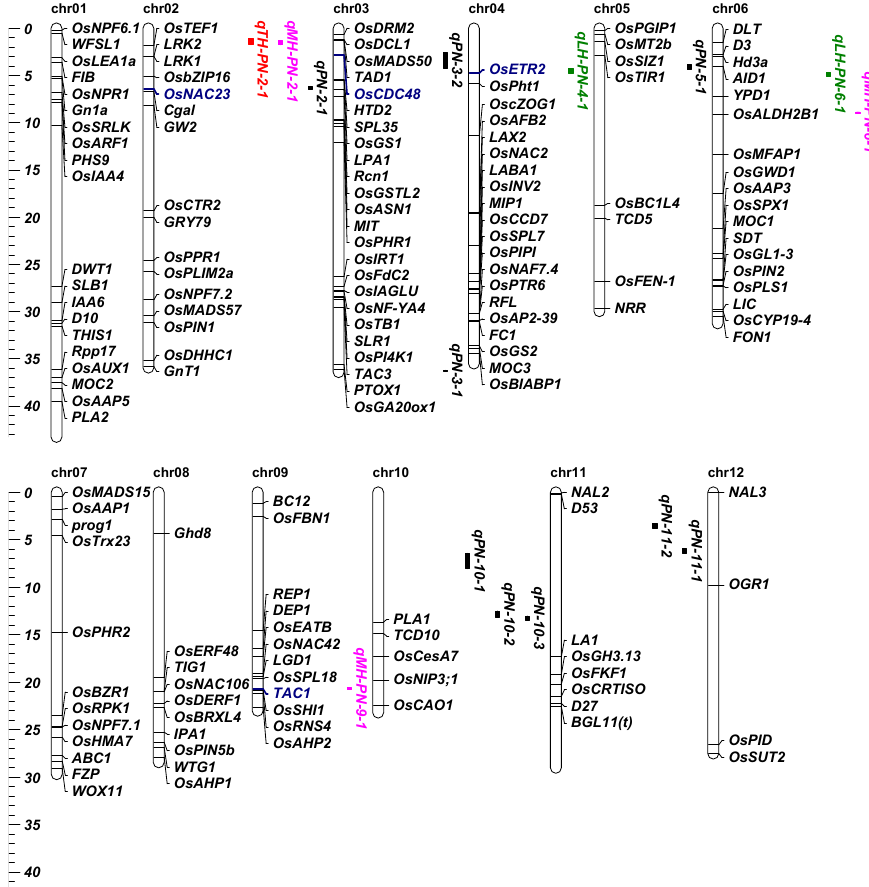
Figure 2. The position of quantitative trait locus (QTLs) for effective panicle numbers (PN) in recombinant inbred lines (RILs) and heterosis-related QTLs in two testcross hybrid populations, and the location comparison of them and PN-related known genes. The QTLs and heterosis-related QTLs located in this study are labeled on the right side of the chromosome; black represents the QTLs. Green, pink and red represent the relative low-parent, middle-parent and transgressive heterosis- related QTLs, respectively. The PN-related known genes were located in the chromosome. Blue represents the known genes covered by QTLs of PN, or heterosis. The Y -axis represents the physical distance (Mb) of the